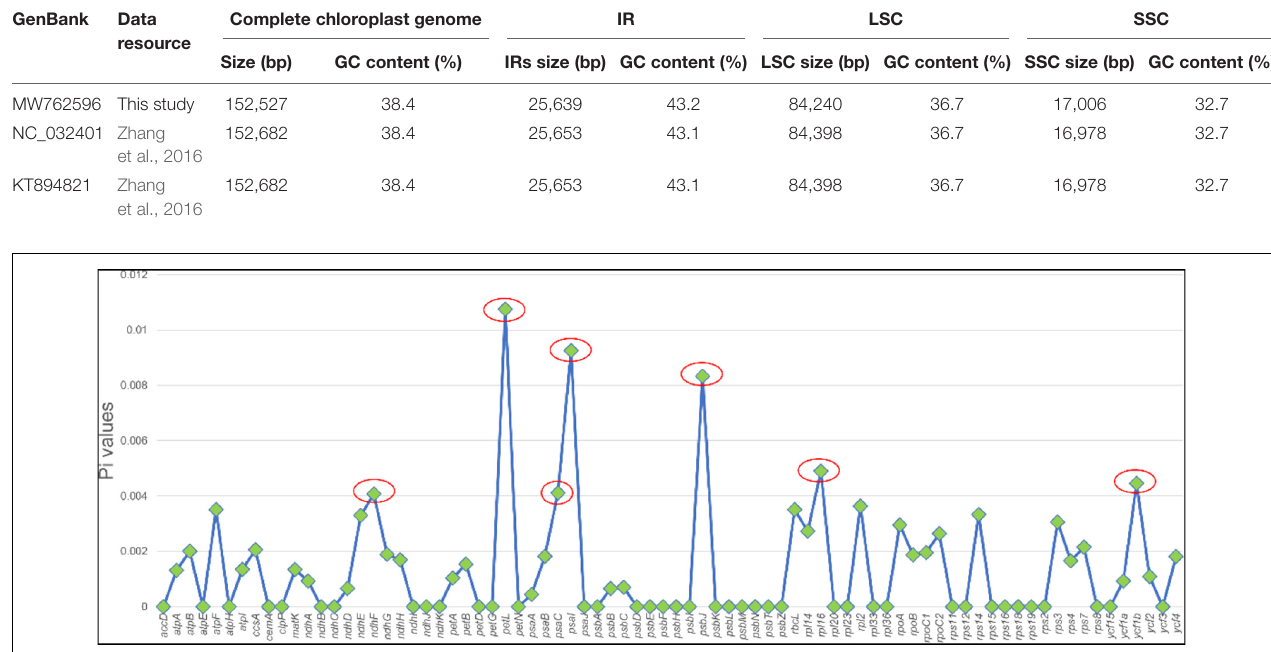
TABLE 3 | A summary of the complete chloroplast genome, IR, LSC and SSC length (bp) and GC content of Paeonia veitchii .